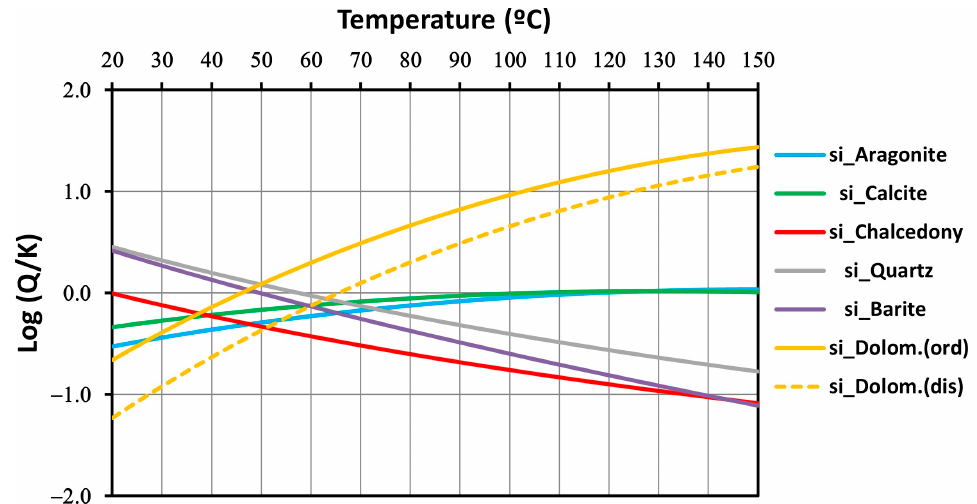
Figure 11. Saturation Indices or Log (Q/K) of selected minerals vs. equilibrium temperature, computed through PHREEQC speciation software, in FNE water sample.